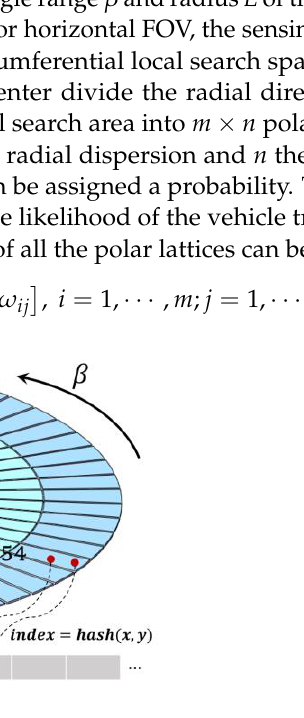
Figure 2. Local search space partition.